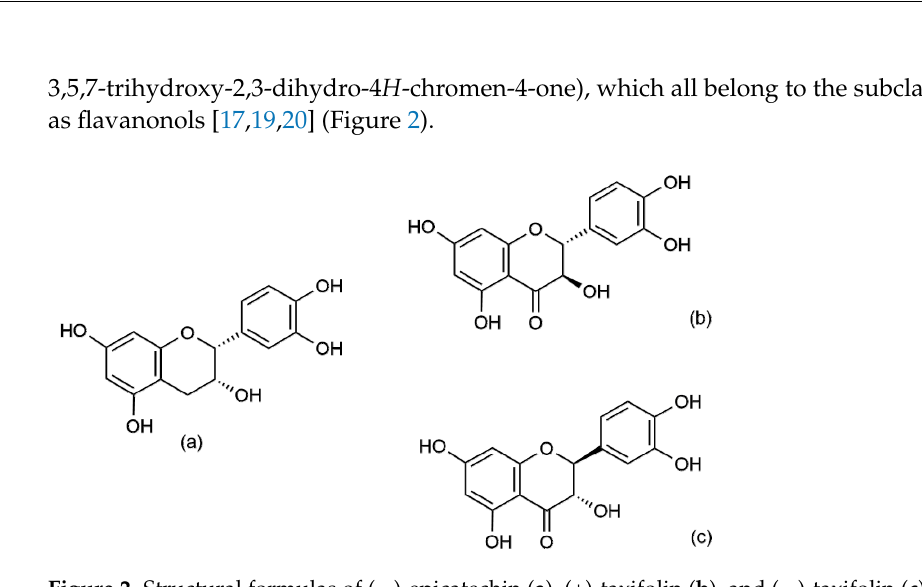
Figure 2. Structural formulas of ( − )-epicatechin ( a ), (+)-taxifolin ( b ), and ( − )-taxifolin ( c ). Both EC and TX are naturally present in various fruits, vegetables, and beverages.